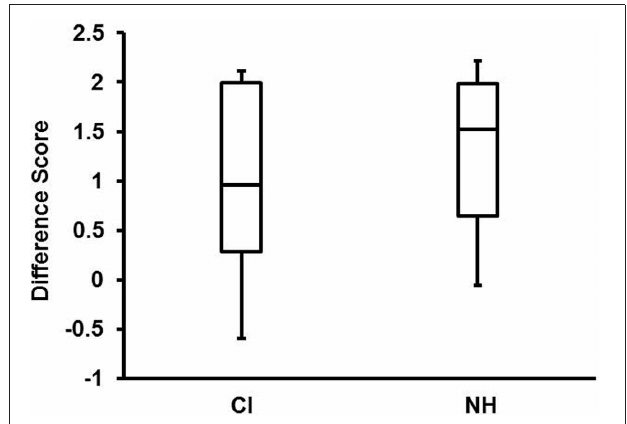
FIGURE 4 | Box plots of difference scores (happy/sad ratings of happy utterances minus ratings of sad utterances) for child CI users and NH children. Top and bottom lines of each box indicate the 75th and 25th percentile, respectively. Lines within each box indicate the median. Top and bottom of the whiskers indicate the highest and lowest